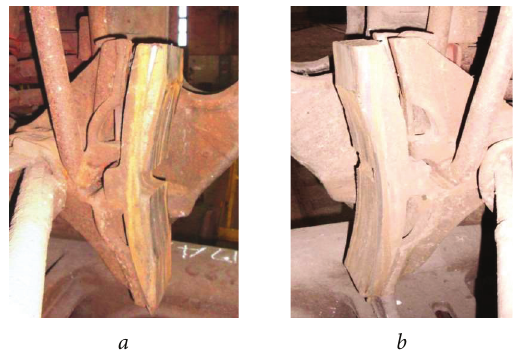
of trains increases, to overcome which thousands of kilowatts of electricity are spent, as well as a ton of diesel fuel. Therefore, there is a need for research in this direction.